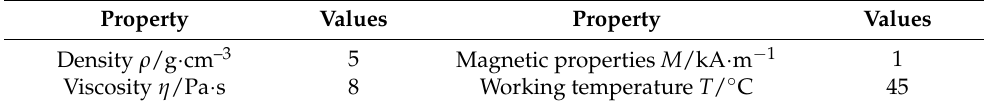
Table 2. Properties of